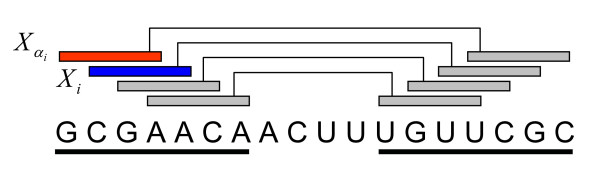
Stem candidates, stem fragments and stem components. A stem candidate (a pair of underlined positions) comprises four overlapping stem fragments. A fragment consists of a 5' (left) component and a 3' (right) component. Xi (blue box) and Xαi (red boxe) are 1-continuous stem components.